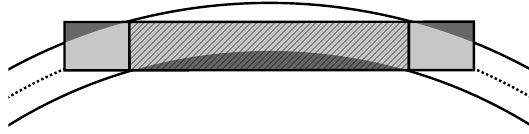
Figure 1: Top view of the train wagon (in dark and light gray) and its curved loading gauge as it passes through a turn. The dark gray areas mark the volumes of the train wagon outside of its loading gauge. The striped volume indicates the volume of the train wagon between its two bogies. The dotted line indicates the wagon’s